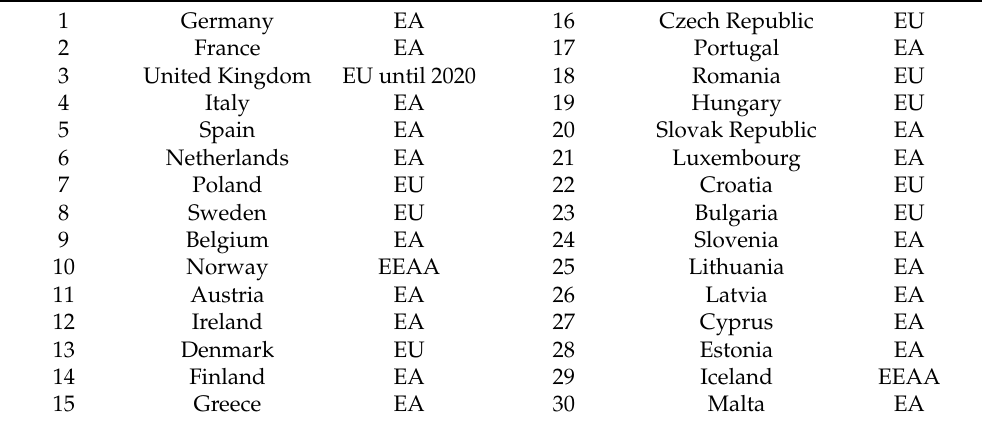
Table 1. The 30 European countries in the dataset, ranked by their GDP (constant 2010 USD) as of 2019 (descending